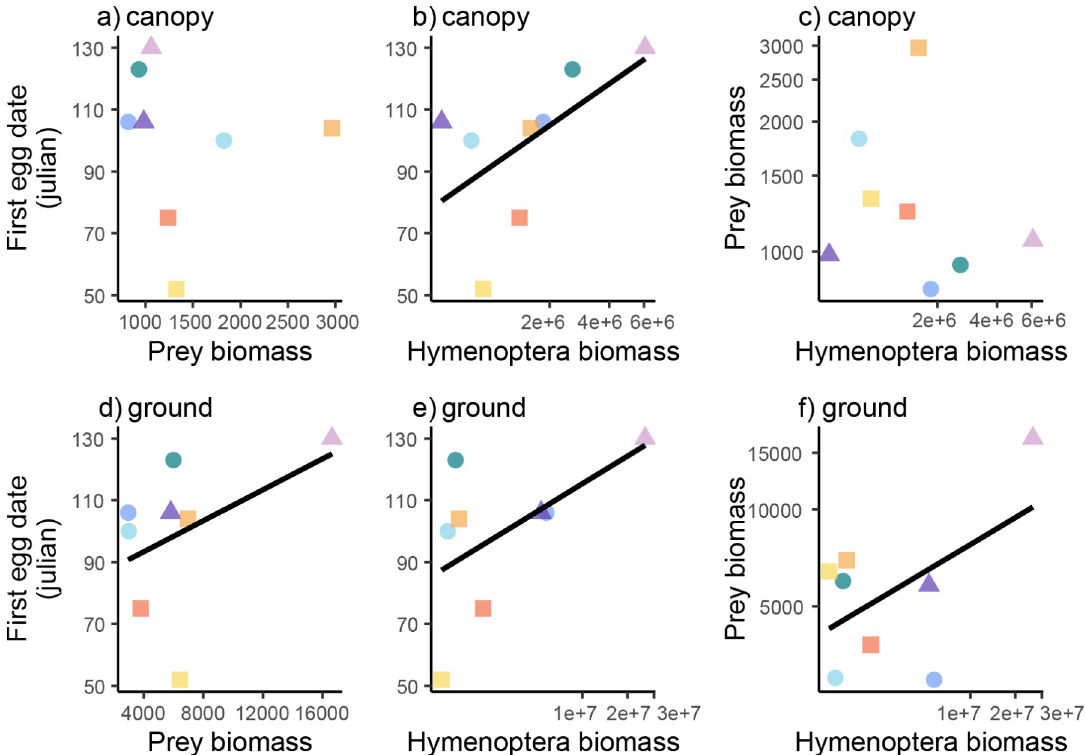
Fig 5. Relationships between the first egg date and territory-level estimates of prey (mg) (left column), first egg date and Hymenoptera biomass (mg) (middle column) and territory-level estimates of prey (mg) and Hymenoptera biomass (mg) (right column). Results presented for plant canopies (top row) and on the ground (bottom row).